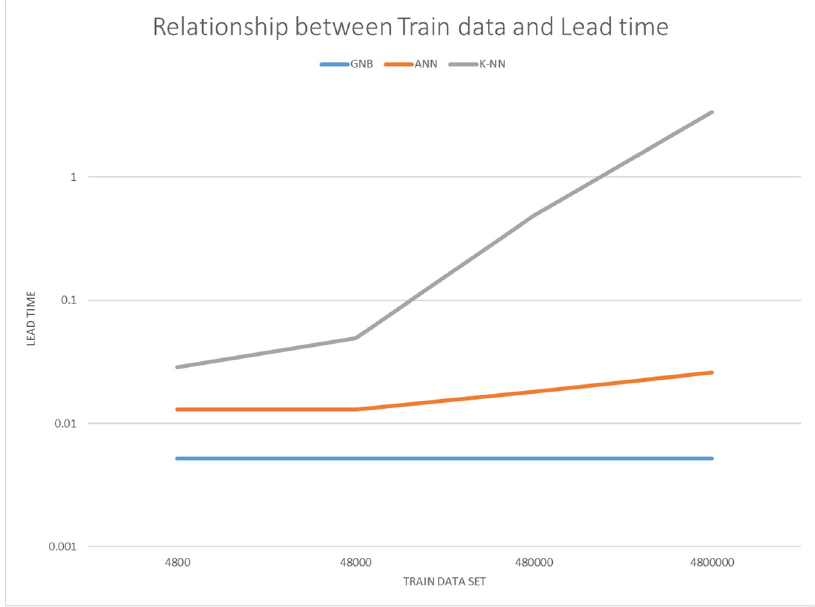
Figure 23. Performance time as a function of amount of learning data.